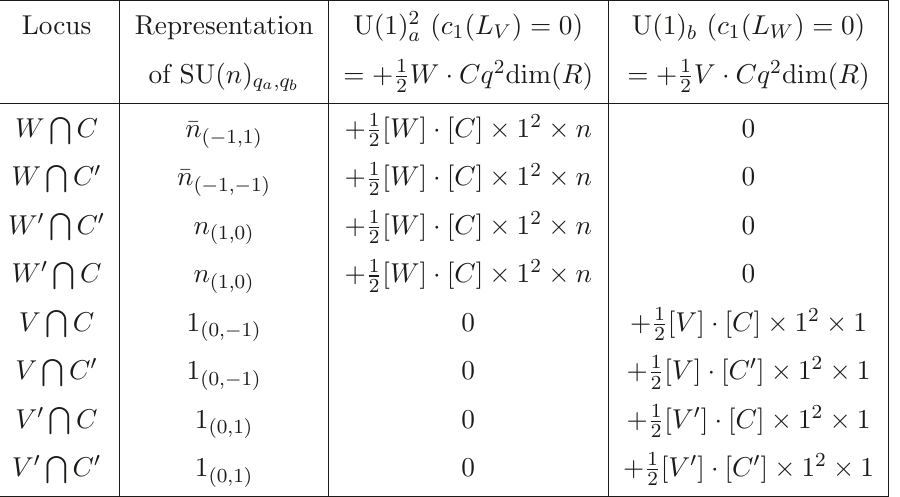
Table 3 . Charged chiral matter from the 3-7 string sector and its anomaly